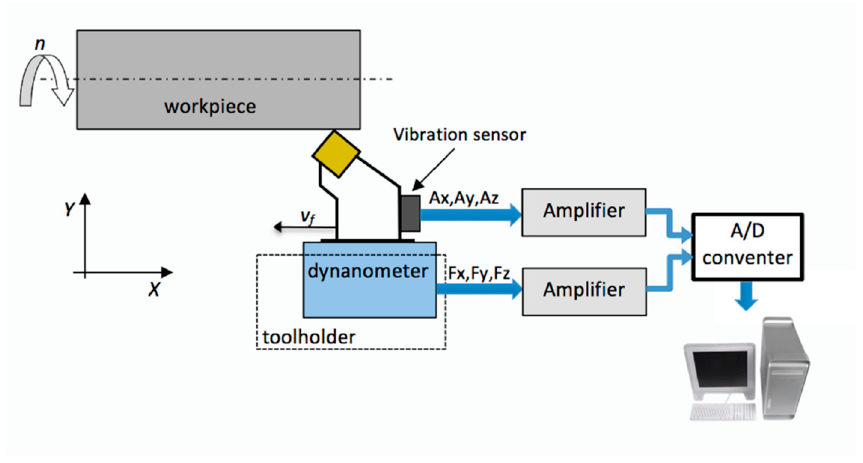
Figure 1. Scheme of measurement line used during the tests.